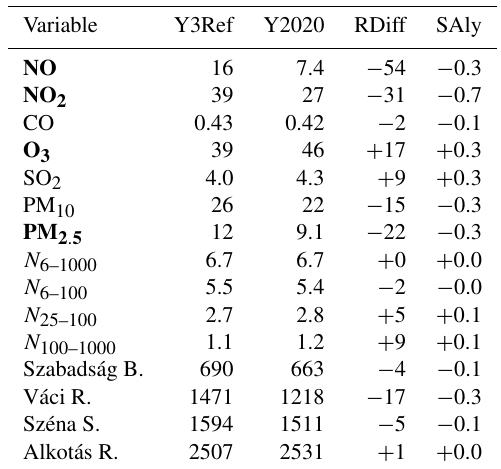
Table 6. Median atmospheric concentrations of NO, NO 2 (both in units of µgm − 3 ), CO (mgm − 3 ), O 3 , SO 2 , PM 10 mass, PM 2 . 5 Bridge, Váci Road, Széna Square and Alkotás Road in the average reference year comprising 2017–2019 (Y3Ref) and year 2020